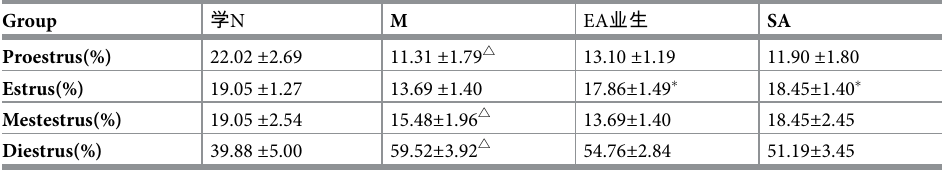
Table 1. The percentage of offspring at each stage of the estrus cycle during 4 th week to 7 th week in four groups.